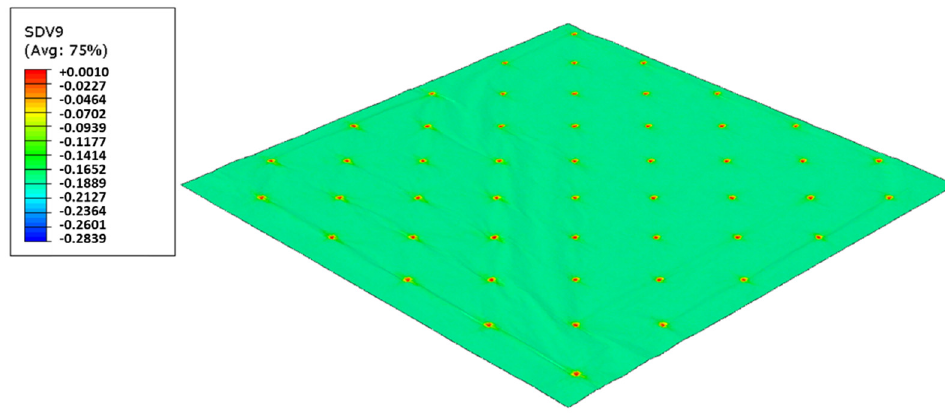
Figure 21. Micro die 60 Sh-A (SBR PR), Plastic field.